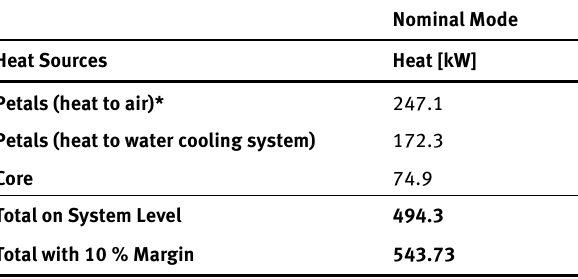
Table 2: Greenhouse thermal budget in nominal mode (worst case).